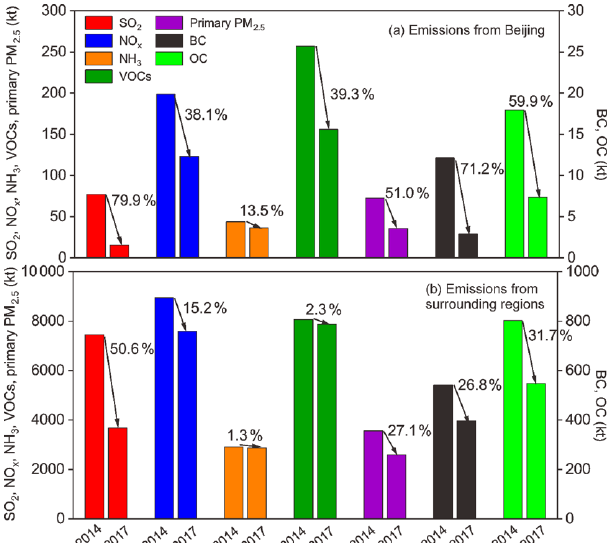
Figure 6. Changes in the anthropogenic emissions of SO 2 , NO x , NH 3 , VOCs, primary PM 2 . 5 , BC, and OC in (a) Beijing and (b) its surrounding regions from 2014 to